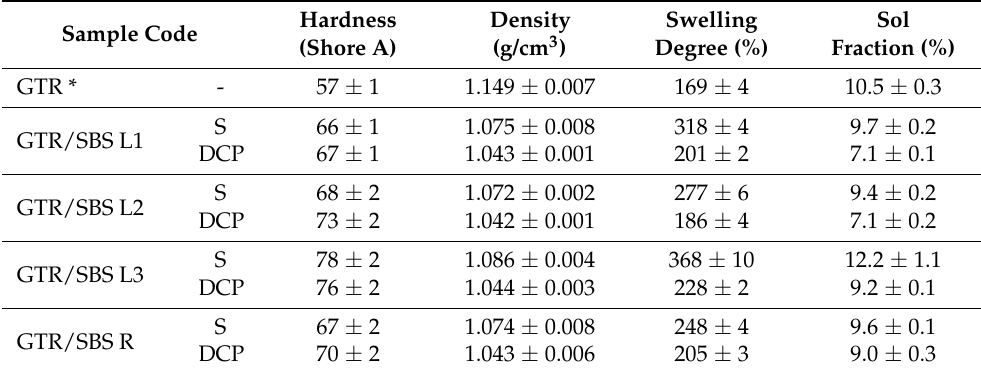
Table 4. Hardness, density, swelling degree, and sol fraction of GTR/SBS